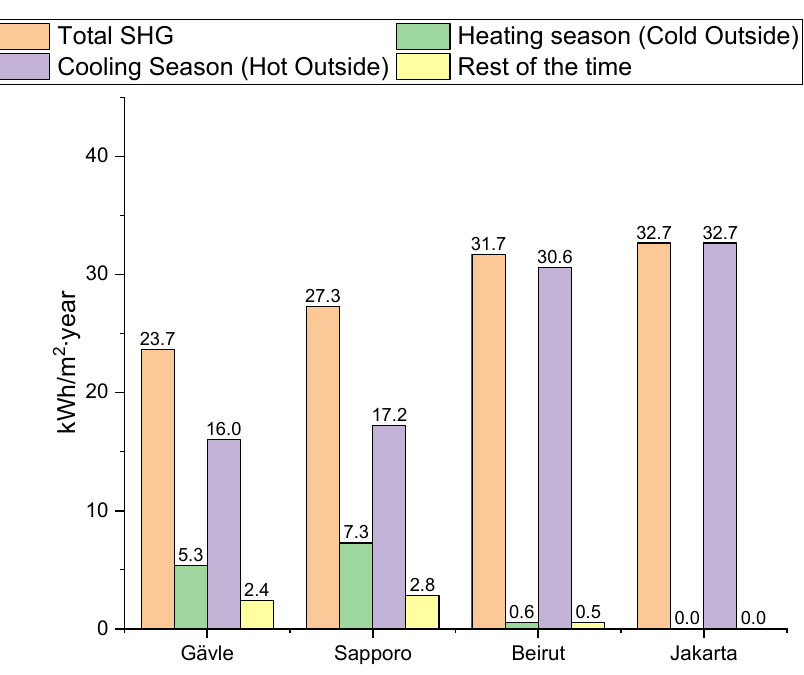
Figure 18. SHGs for L0 in different locations.